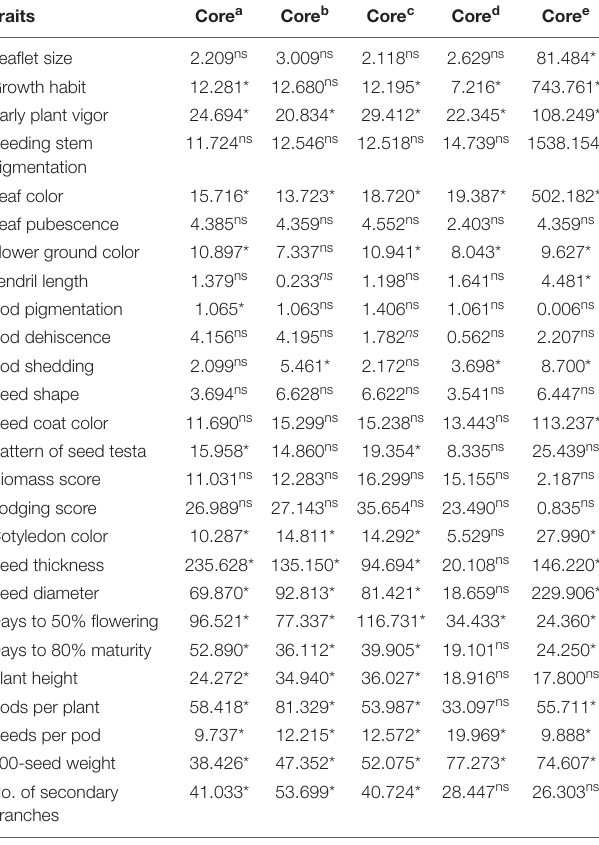
TABLE 2 | Comparison of the Shannon–Weaver diversity index (SDI) of the entire lentil collections to lentil core sets derived from different datasets and strategies. Traits